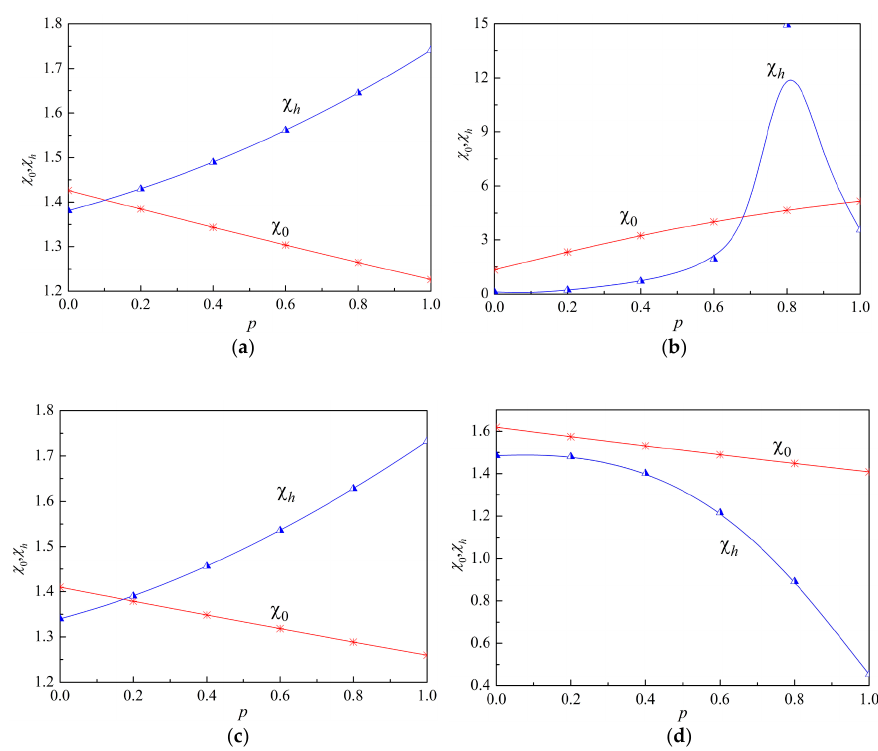
Figure 5. Ellipticity of particles on lower and upper surfaces versus the gradient parameter. ( a ) kh = π , Mode 1, ( b ) kh = π , Mode 2, ( c ) kh = 2 π , Mode 1, ( d ) kh = 2 π , Mode